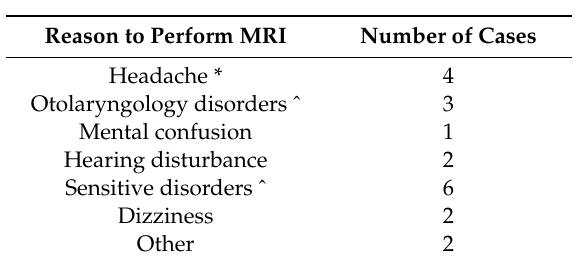
Table 2. Reasons for initial MRI by which the incidental low-grade gliomas (iLGGs) were incidentally